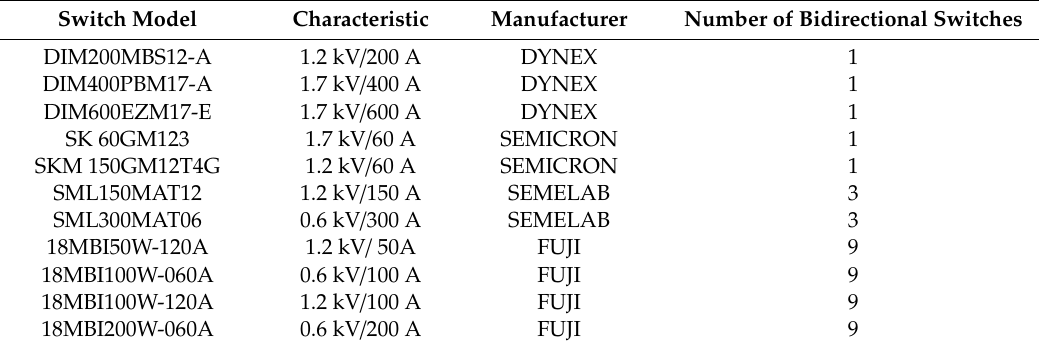
Table 1. Available, selected commercial modules with bidirectional switches.